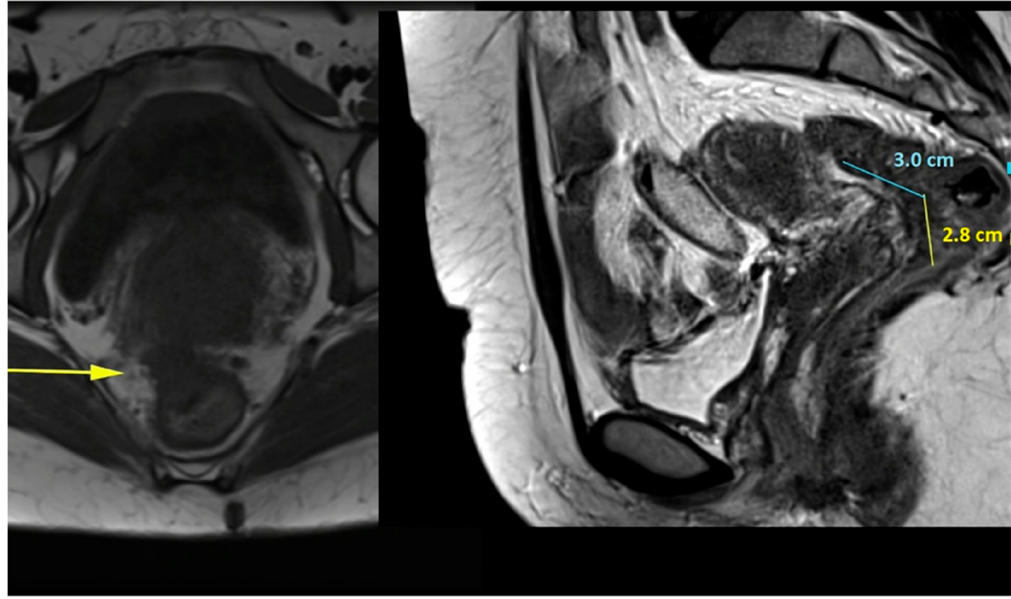
Figure 1. Preoperative MRI image shows deep endometriosis involving the low rectum and vagina.